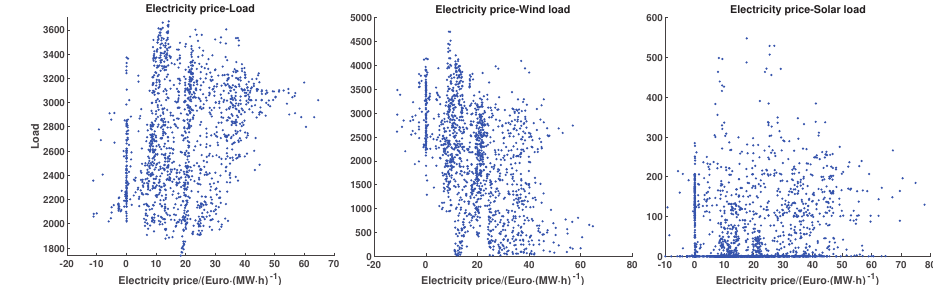
Figure 4. Scatter diagram of electricity price and load in 2020 (20 January–20 March).